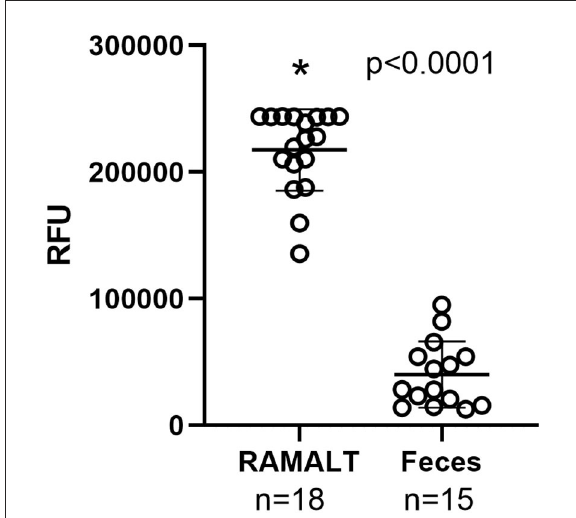
FIGURE2 RT-QuIC testing of RAMALT and feces and relationship to fluorescence. RAMALT samples ( n = 18) have significantly higher relative fluorescent units (RFUs) compared to white-tailed deer fecal samples ( n = 15) ( p < 0.0001). The * symbol indicates RFU